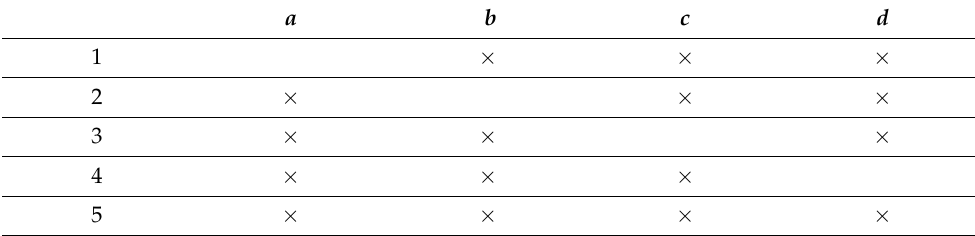
Table 4. A “worst case” context for n =